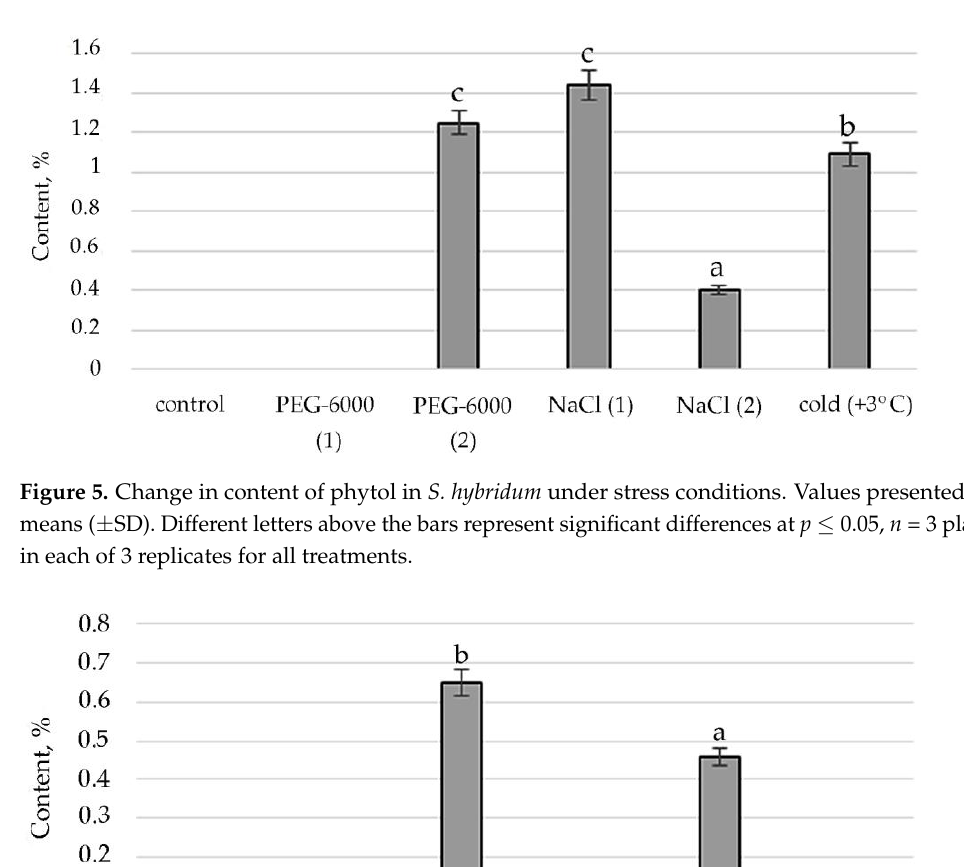
Figure 4. Change in content of tetratetracontane in S. hybridum under stress conditions. Values presented are means ( ± SD). Different letters above the bars represent significant differences at p ≤ 0.05, n = 3 plants in each of 3 replicates for all treatments.